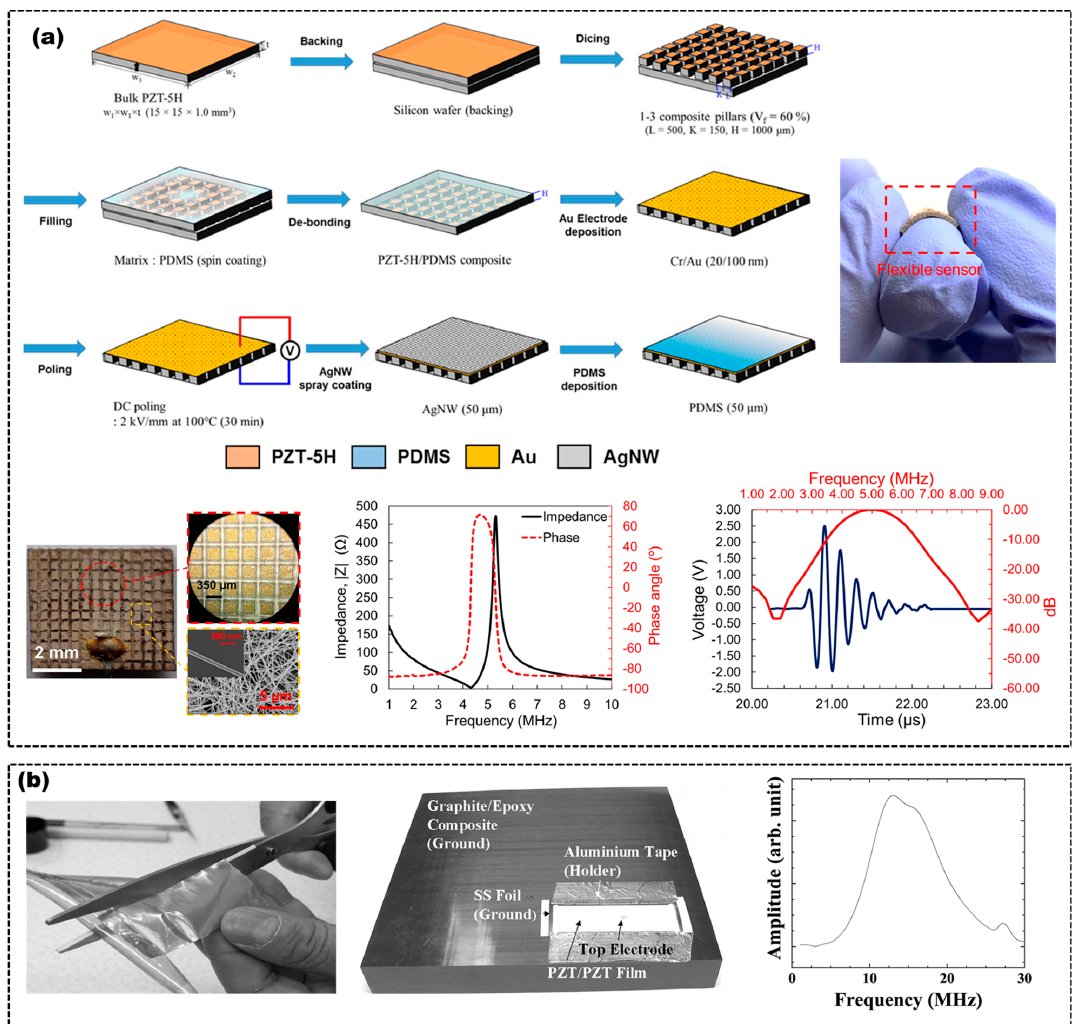
Figure 3. ( a ) Fabrication process of a flexible single ‐ element transducer based on PZT/PDMS 1 − 3 piezocomposite ( top left ), photographs ( bottom left ), flexibility test ( top right ), electrical impedance and phase angle ( bottom middle ) and response waveform and frequency spectrum ( bottom right ) of the transducer. Adapted from [21,24]. ( b ) Photograph of a ZnO/Al foil flexible active material ( left ), photograph ( middle ) and frequency spectrum ( right ) of a PZT/PZT flexible transducer. Adapted from [1,33].